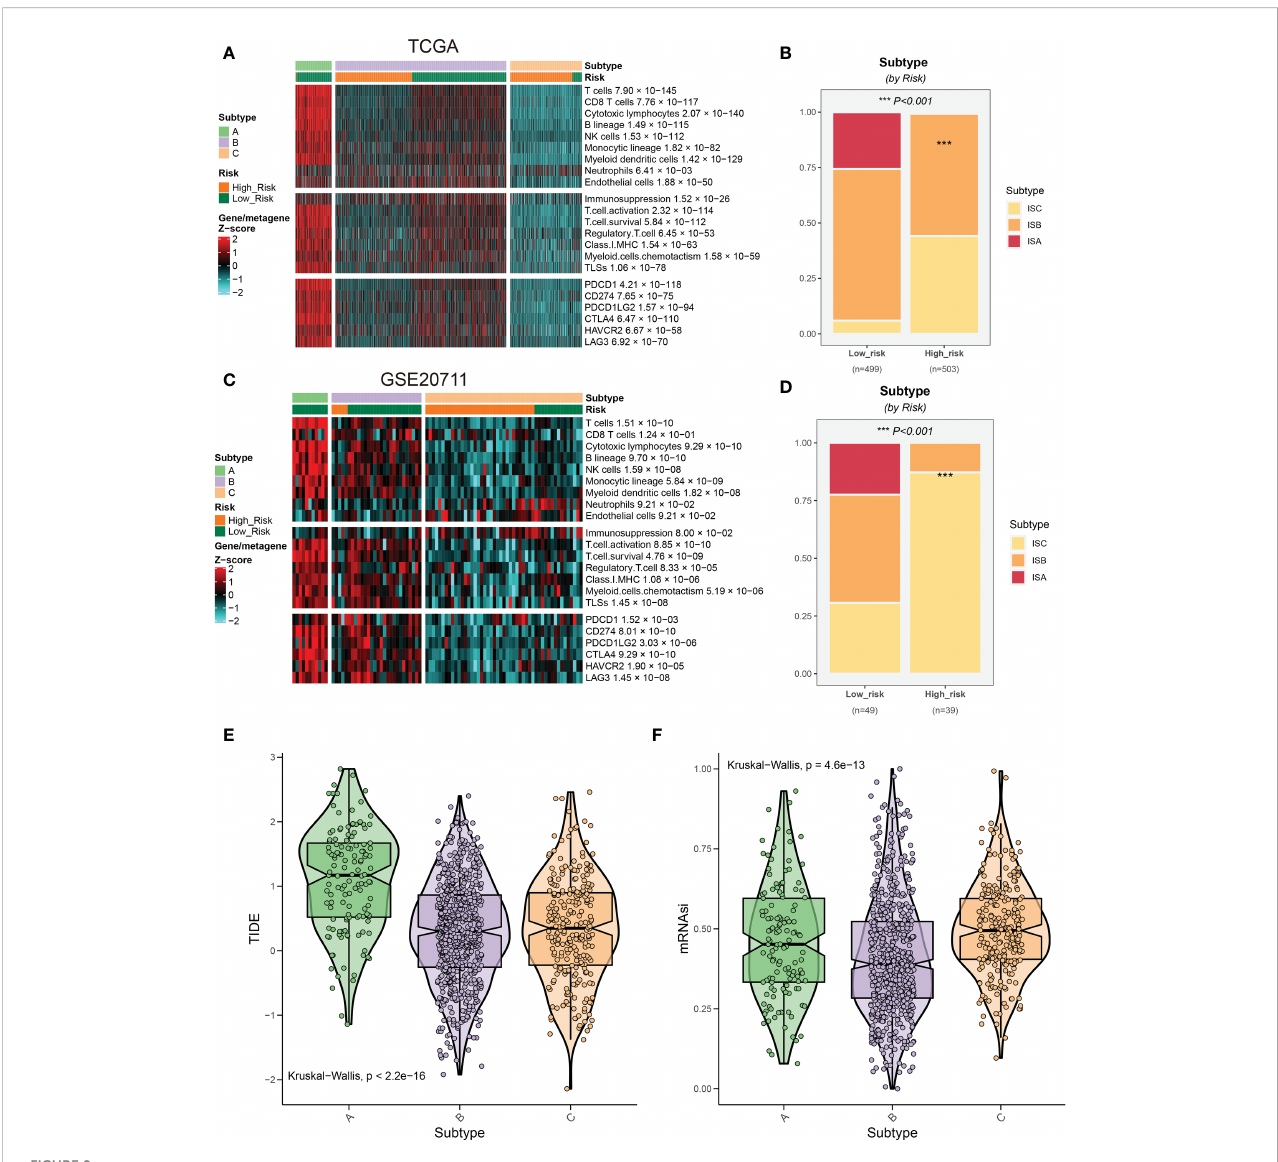
FIGURE 9 Relationship between risk groups and immune subtypes. (A) Patients in the TCGA cohort were divided into three immune subtypes based on the immune in fi ltrating landscape. (B) The distribution of three immune subtypes between the two risk groups. (C, D) Validation of the immune subtypes and their distribution in GSE20711. (E, F) Association of risk scores of immune subtypes with response to